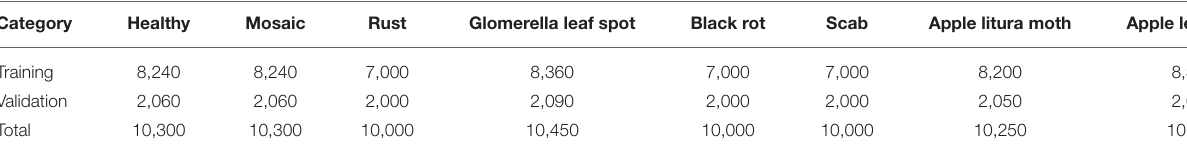
TABLE 1 | The composition of apple leaf disease identification data set (ALDID).